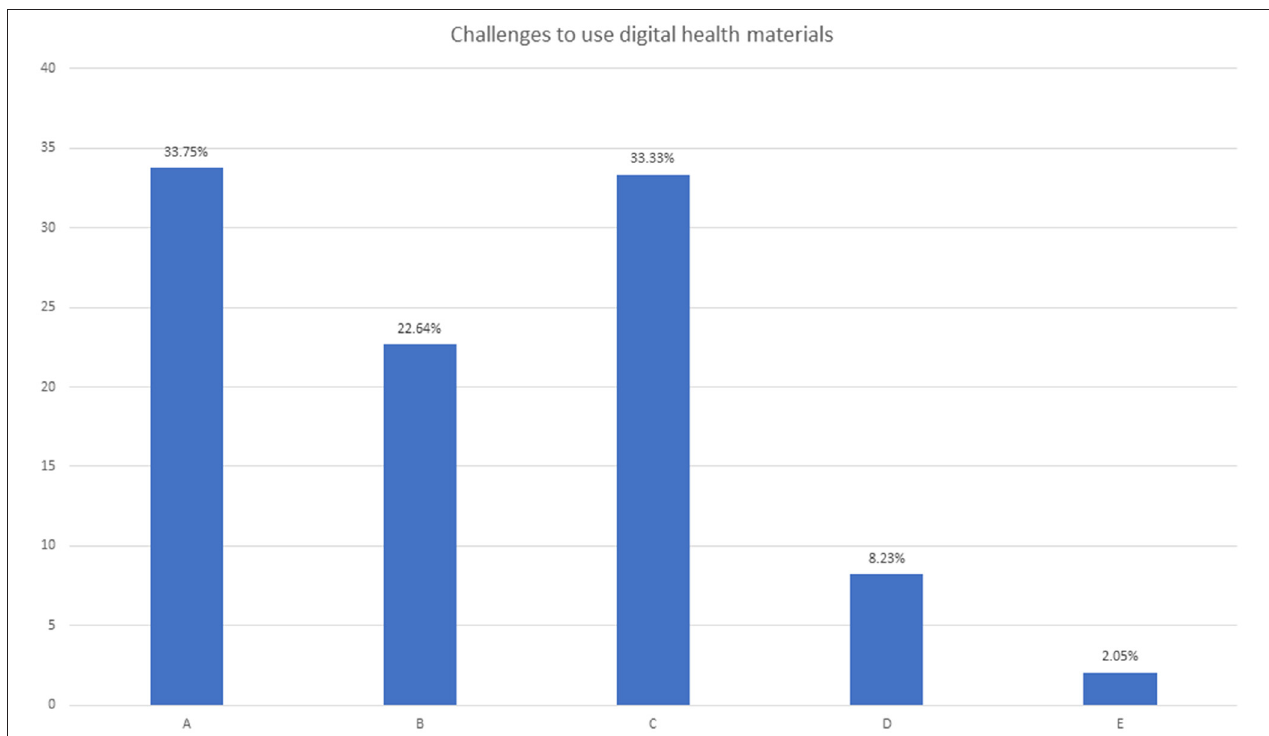
FIGURE 2 | Responses regarding challenges to using digital health materials. In the figure, A = Lacking proper training, B = Lacking the monitoring and supervision, C = Lacking the technical support, D = None, E = all of the above.